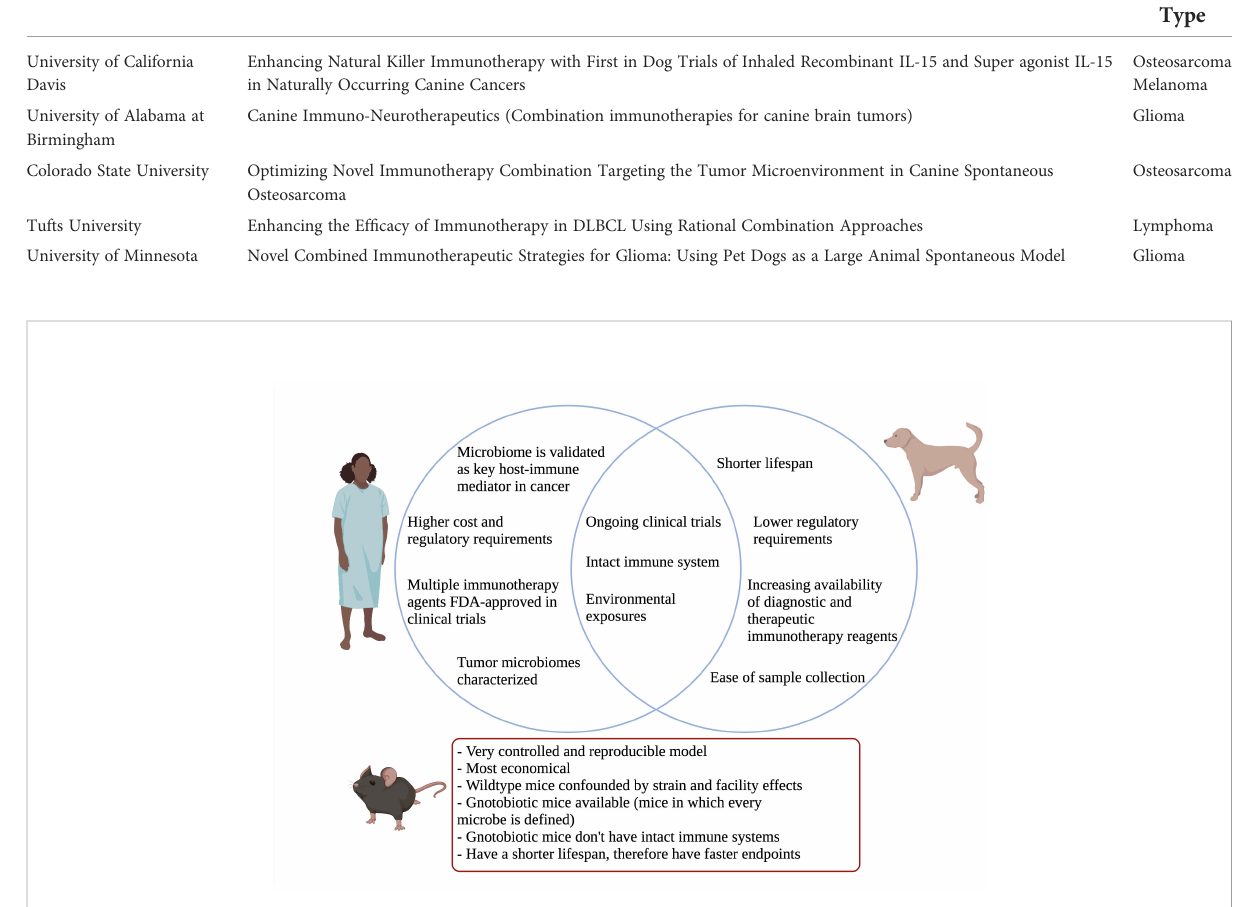
FIGURE 1 Venn diagram comparing relevant aspects of canine model to humans. Important mouse model differences highlighted